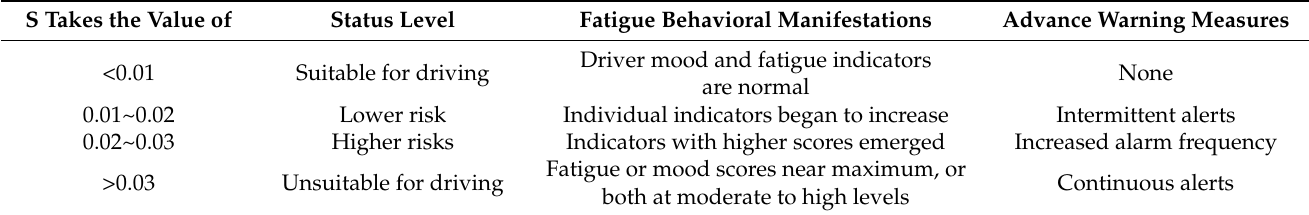
Table 3. Driver status